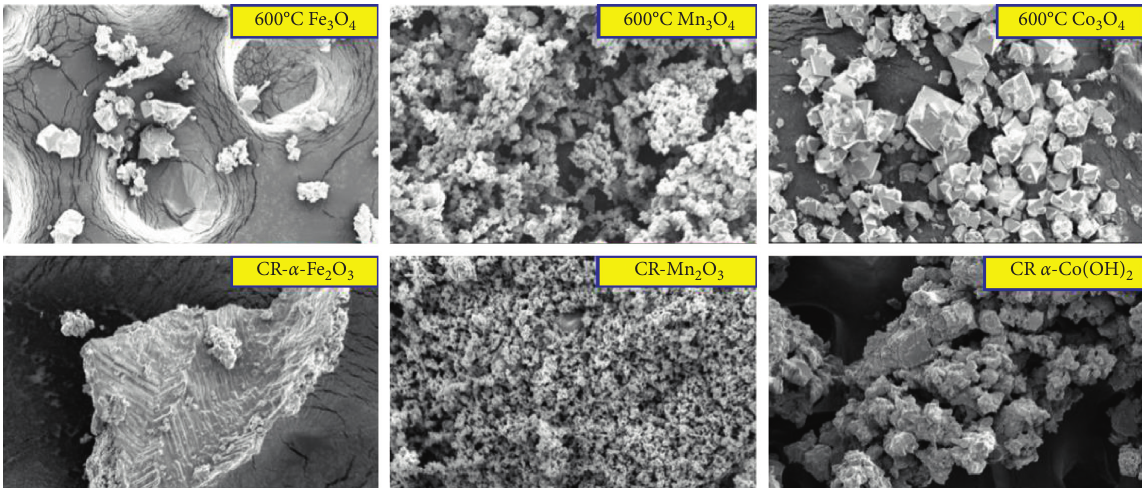
Figure 6: SEM images of Fe 3 O 4 , Mn 3 O 4 , and Co 3 O 4 metal oxide NPs obtained from the calcination of [EMIM-Cl][FeCl 2 ], [EMIM-Cl] [MnCl 2 ], and [EMIM-Cl][CoCl 2 ], respectively, at 600 ° C, whereas α -Fe 2 O 3 , Mn 2 O 3 , and α -Co(OH) 2 were obtained from chemical treatment.